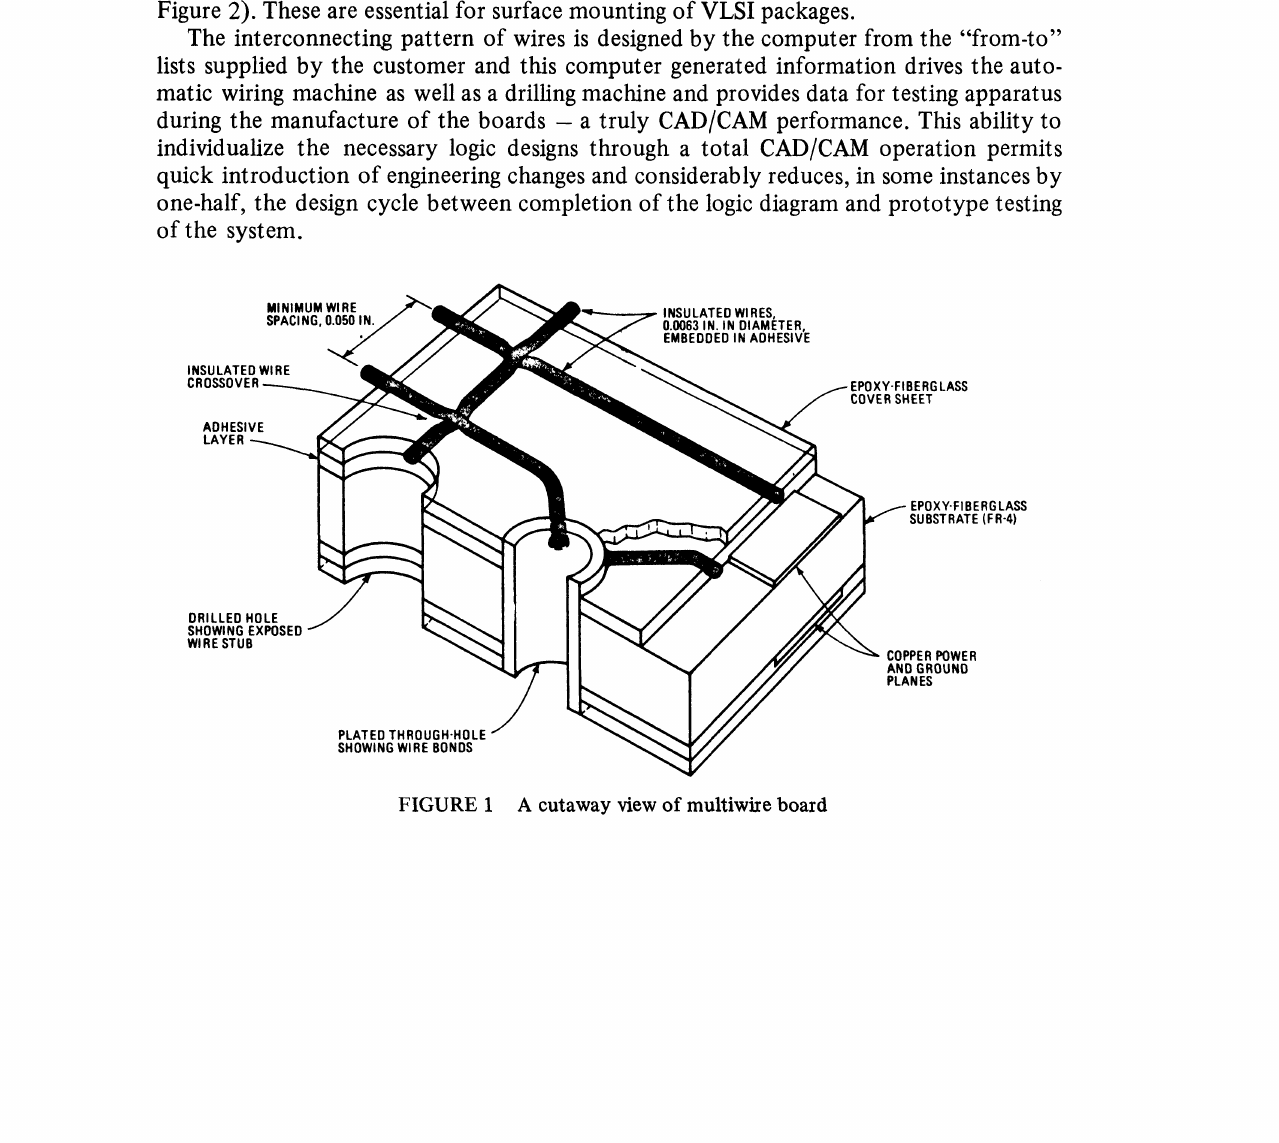
FIGURE A cutaway view of multiwire